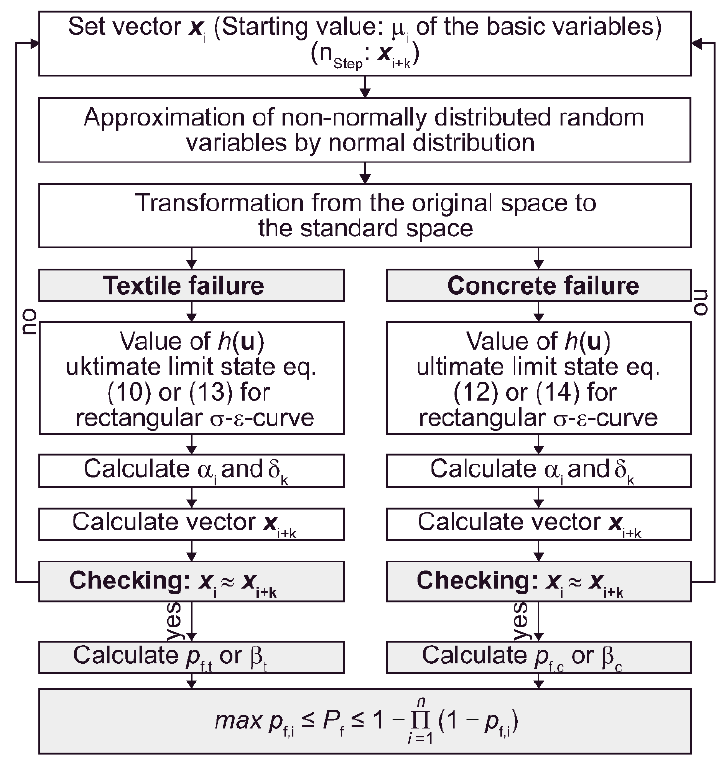
Figure 5. Flowchart for the calculation of the failure probability according to first-order reliability method (FORM) under the assumption of a linear σ–ε diagram for the concrete.